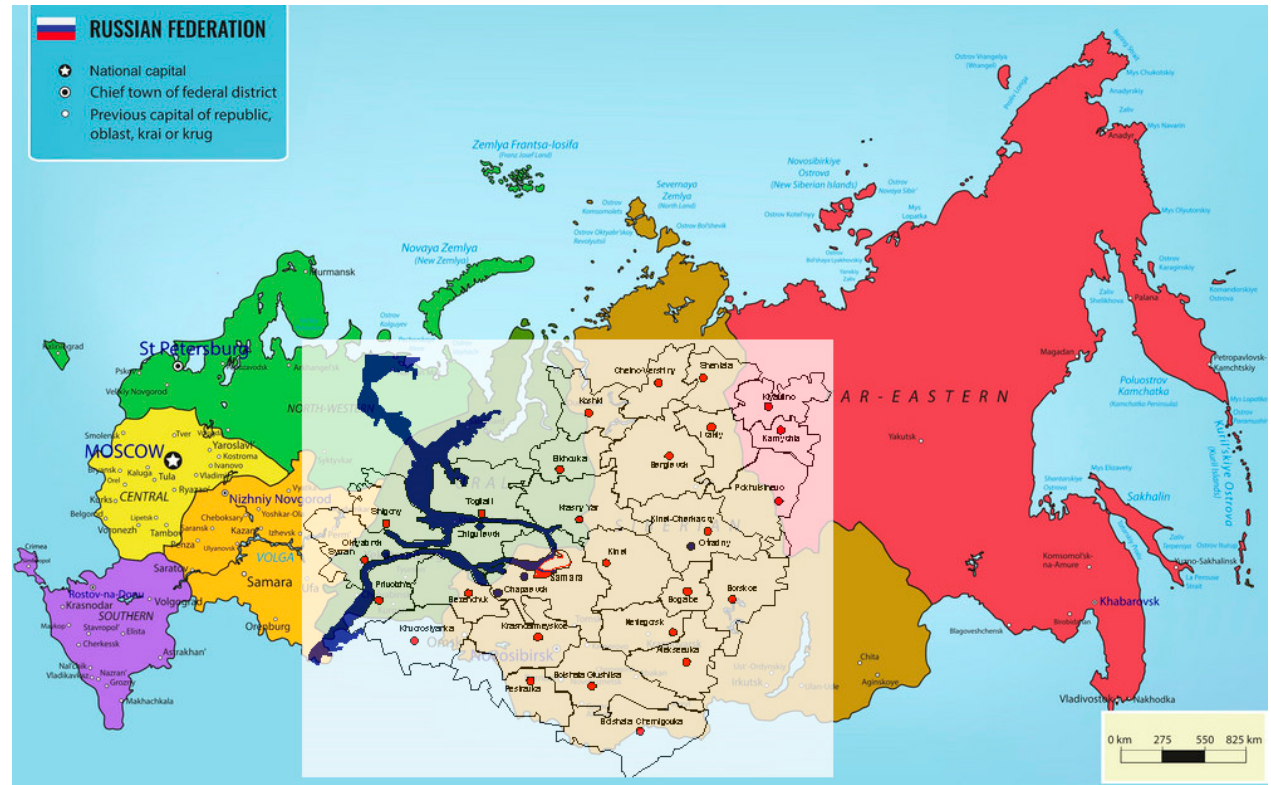
Figure 2. The Middle Volga region (the Samara region).